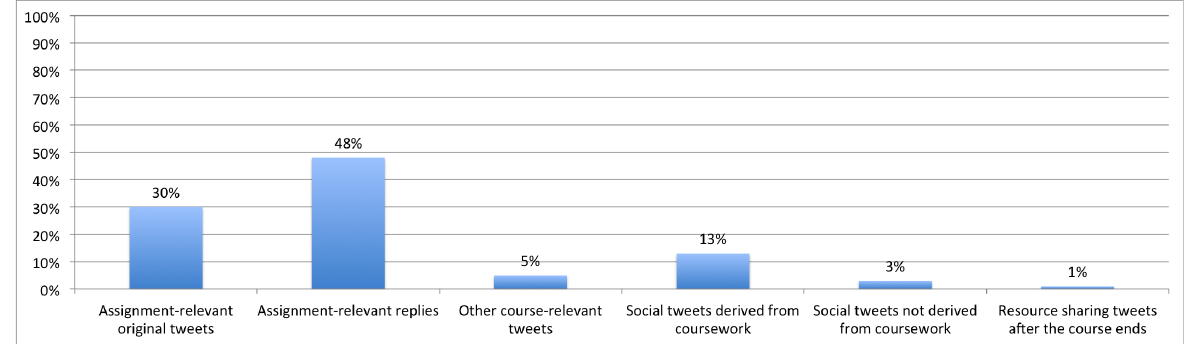
Figure 1. Tweet distribution by